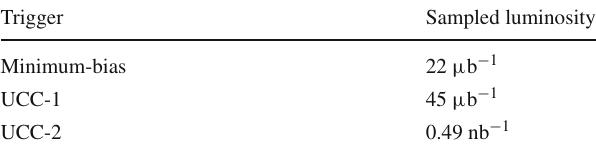
Table 1 The luminosities sampled by the triggers used in the analysis